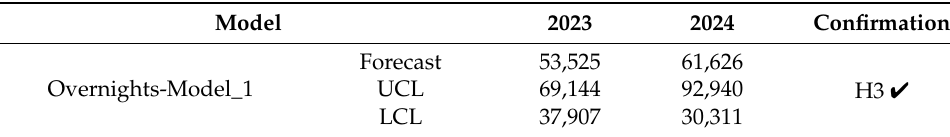
Table 6. Forecasting the number of overnight stays. Figure 12. Estimated values of overnight stays for the period 2023 and 2024.